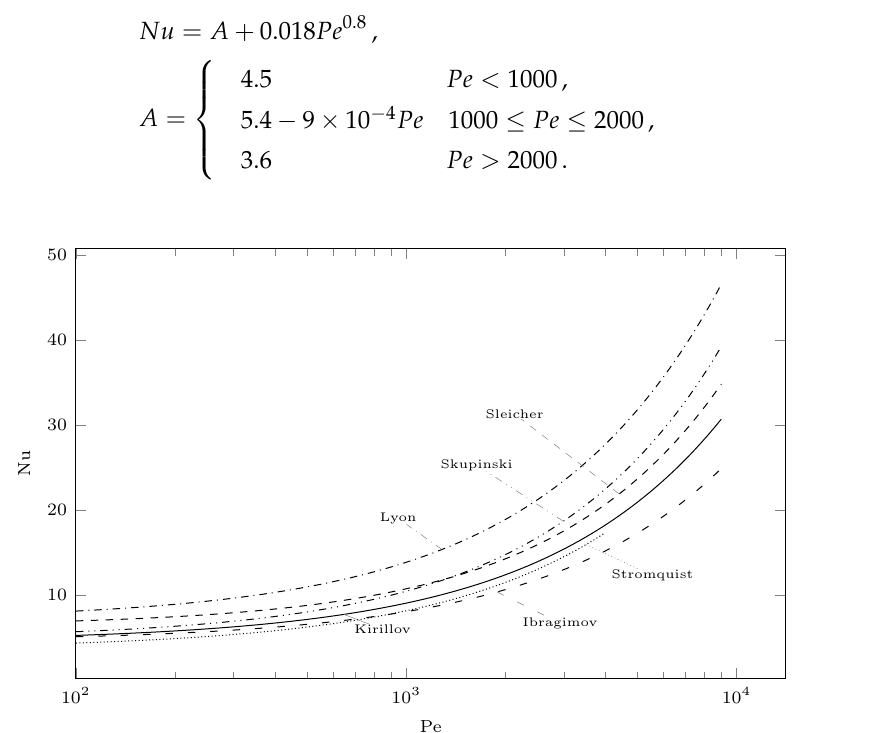
Figure 4. Cylindrical pipe tests (constant heat flux). Nusselt numbers from different experimental data in Equations (40)–(45) as a function of the Peclet